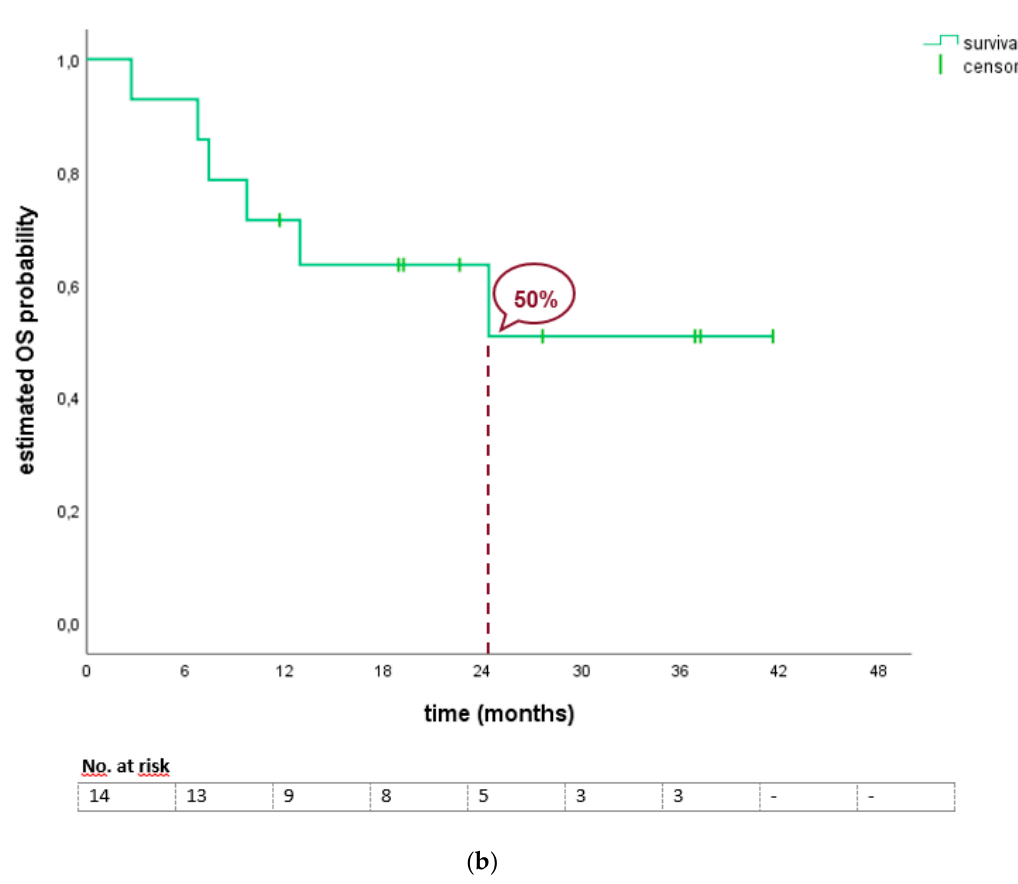
Figure 2. ( a ) Duration on treatment of ROS1 positive patients. ( b ) Overall Survival of ROS1 positive patients since start of lorlatinib treatment.